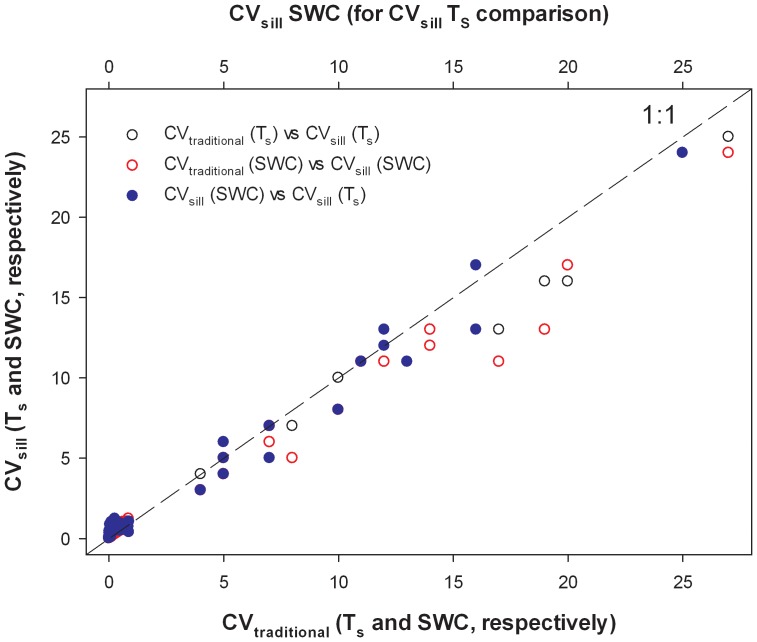
Coefficient of variation calculated by dividing the standard deviation by the mean (CVTraditional) versus coefficient of variation calculated using the semivariogram sill (CVSill) for Ts, SWC, and CVSill for Ts versus SWC. Dotted line is 1∶1.